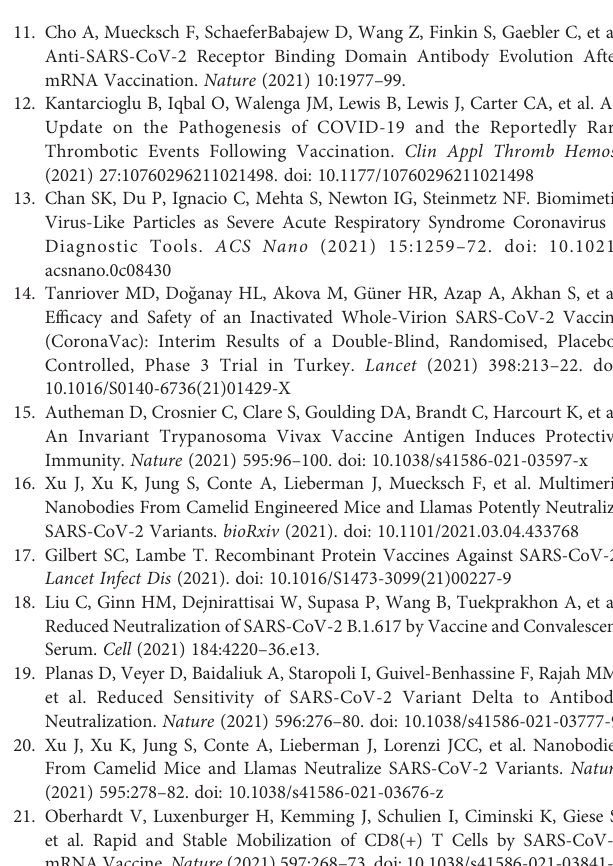
Supplementary Figure 2 | Immunization with RBD9.1 antigenic peptide ef fi ciently induced neutralizing antibody productioninBalb/cmice. (A) RBD9.1 and HBV peptide amino acid sequence information. (B) RBD9.1, RBD and HBV peptide immunization strategy. (C) SARS-CoV-2RBDrecombinantproteinexpressedinFreeStyle293Fcells and separated by af fi nity chromatography were veri fi ed by silver stain. (D) The production of HBV-speci fi c antibodies from mice immunized with HBV peptide. (E) RBD9.1sequence,withsinglepointmutations(red)toalanine. (F) Sequencealignment for the RBD proteins ofSARS-CoV-2 andSARS-CoV. TheRBM regionwas markedin red, and the same amino acid sequence of the RBD protein of SARS-CoV-2 and SARS-CoV was marked in light blue. The amino acid sequence of RBD9.1 in SARS- CoV-2 RBD is marked with green dots. (G) Sequence alignment within the amino acid sequence of RBD9.1 of WT, P.1, B.1.1.7, B.1.351, B.1.617.1 and B.1.617.2 strains. Supplementary Figure 3 | Related to Figure 3 . (A) Flow cytometric diagram of the proportion of CD19 - CD138 + plasma cells. (B) ELISPOT results of RBD-speci fi c plasma cells in the spleen and bone marrow of mice after last immunization. Results were expressed as the numbers of RBD-speci fi c IgG spots per 5 × 10 5 splenocytes of each mouse, subtracted those from the corresponding DMSO groups. The stimulation with an equal volume of media was performed as the negative control. Data were representative of two independent experiments. Supplementary Figure 4 | Related to Figure 4 . The expression of CD25 (A) and CD69 (B) (gated on CD4+ T cells) on the 7th day after the last immunization. Supplementary Figure 5 | Related to Figure 4 . The expression of CD137 (A) and CD69 (B) (gated on CD8 + T cells) after 10 m g/mL P45 or HBV peptide stimulation for 24 hours, normal media was used as negative control.